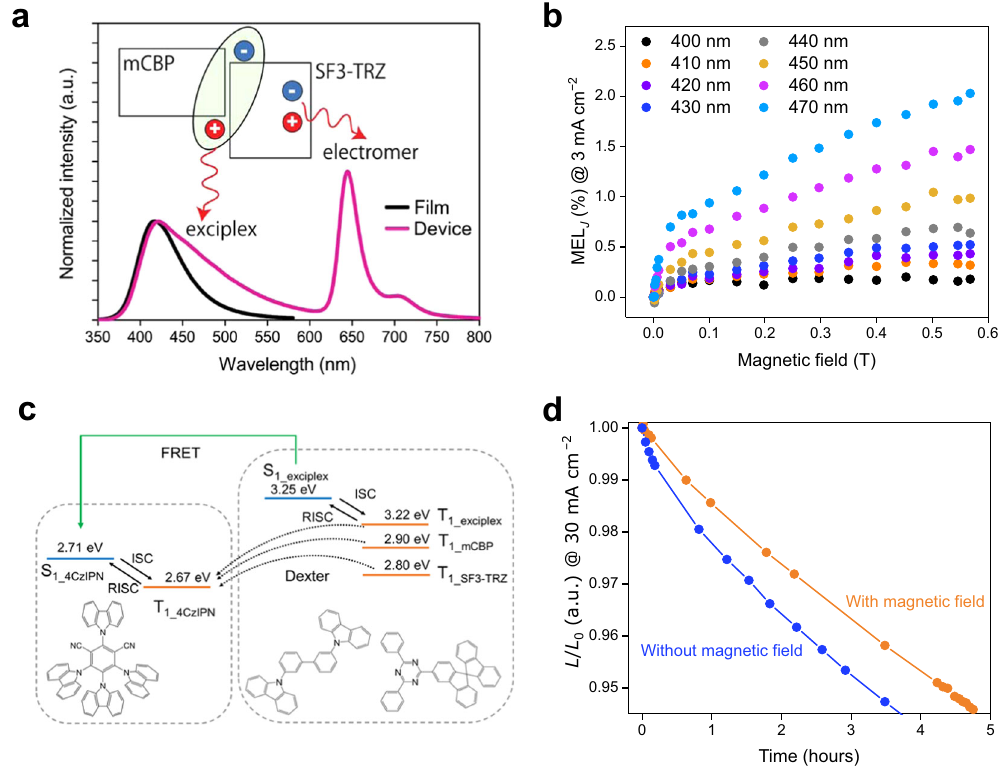
Fig. 4 Origin of the degradation event in TADF-OLEDs. a Photoluminescence spectrum of the co-deposited fi lm of 50 wt%-mCBP:SF3-TRZ, and electroluminescence spectrum of the device based on the undoped emission layer (only mCBP). b Magneto-electroluminescence pro fi les of the device based on the undoped emission layer with various emission wavelengths. c Schematic of energy transfer to TADF emitters in degraded devices. d Luminance decay curves of 4CzIPN-based OLEDs under constant high current of 30 mA cm − 2 . The pixels were fabricated on same substrate at the same